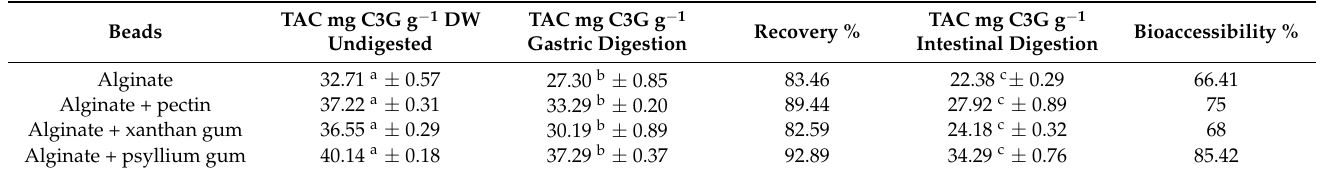
Table 1. Effect of gastrointestinal digestion on the anthocyanin profile of alginate-based beads.